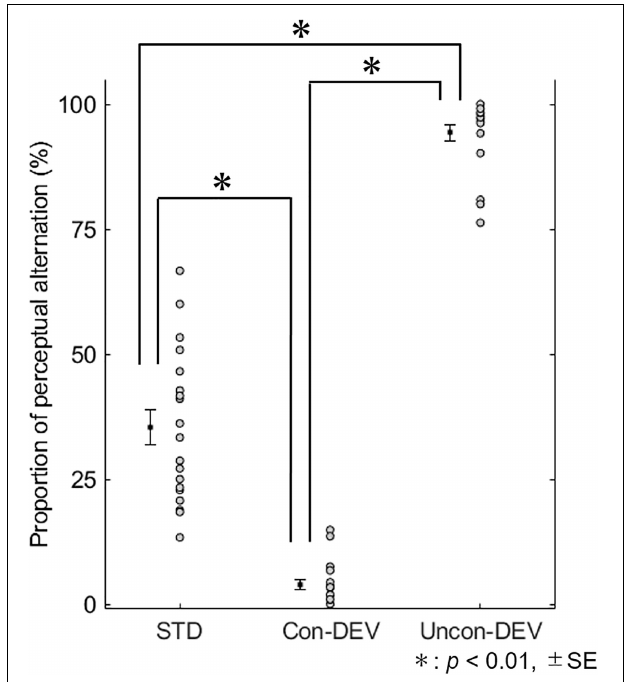
FIGURE 2 | Proportion of perceptual alternation for each condition. The proportion of perceptual alternation for all participants are shown for each condition. The mean proportion is indicated by black-filled square with ± SE. The proportion was significantly higher in the Uncon-DEV condition than that in the STD condition. On the contrary, the proportion was significantly lower in the Con-DEV condition than that in the STD